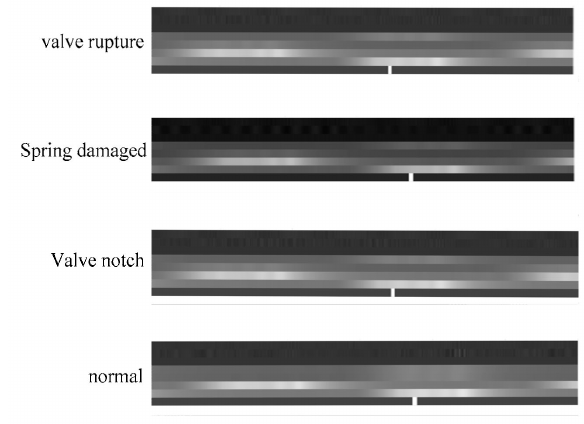
Figure 6. Model input data under four working conditions.